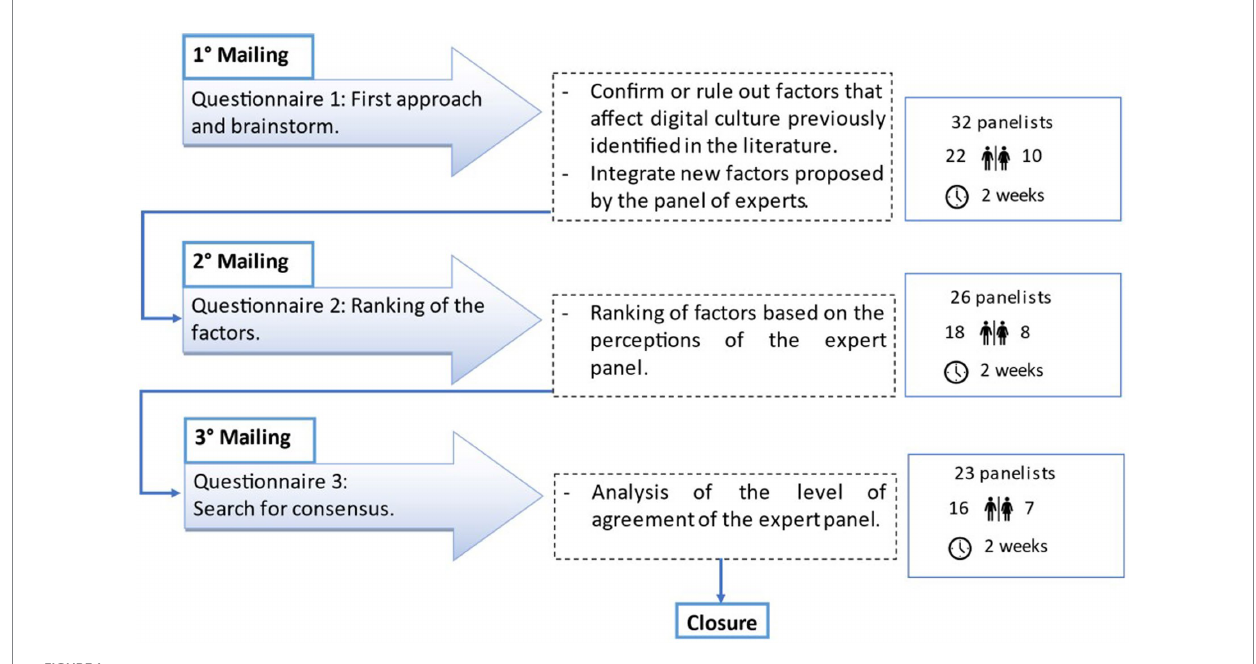
FIGURE 1 Data gathering